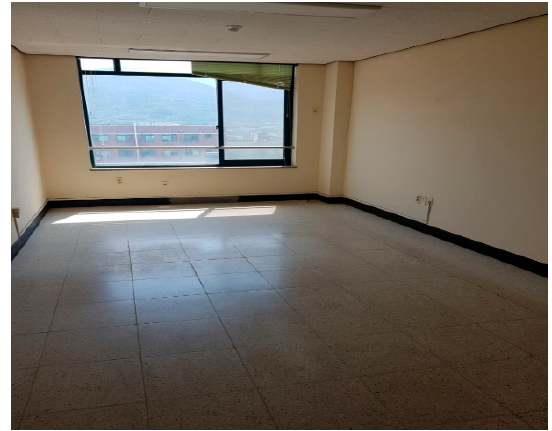
Figure 3. Fourth floor of building No. 9 used for the temperature measurement.